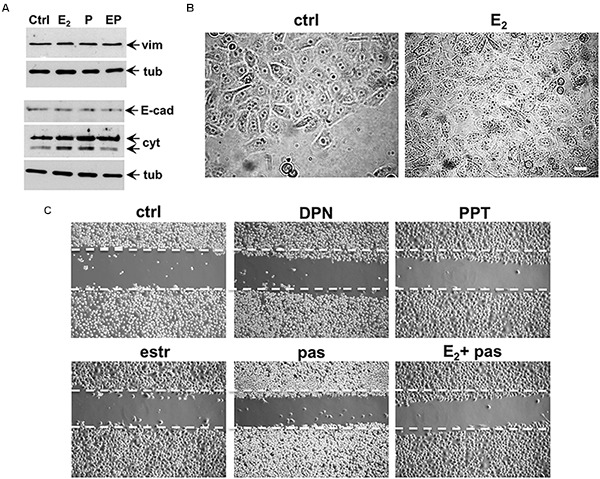
Effect of estradiol and pasireotide on EMT, morphology and motility of EPN cells. Quiescent EPN cells were untreated or treated for 48 h with the indicated compounds. Estradiol was used at 20 nM, pasireotide at 0,1 μM, PPT and DPN both at 3 nM. In panel (A), lysate proteins (2 mg/ml) were prepared, separated by SDS-PAGE and transferred to nitrocellulose membrane. Filters were immune-blotted using the antibodies against the indicated proteins. The blots are representative of two different experiments. In panel (B), the cells were analyzed for morphological changes using contrast-phase microscopy. Bar, 10 μM. In panel (C), the cells were wounded and then left unstimulated or stimulated with the indicated compounds. Cytosine arabinoside (20 μM) was added to the cell medium to avoid cell proliferation. Contrast-phase images in panel (B,C) are representative of 3 different experiments.